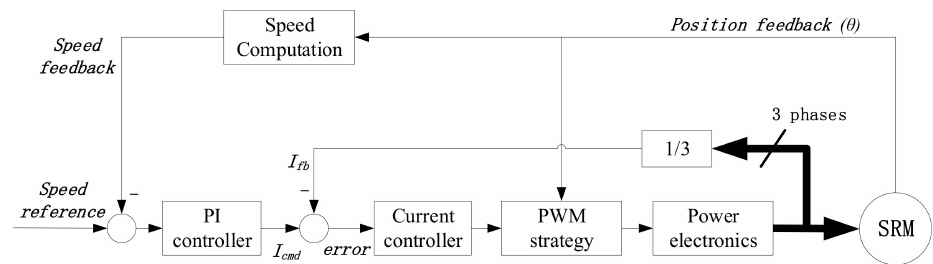
Figure 5. Control principle of SRM speed-adjustment system.